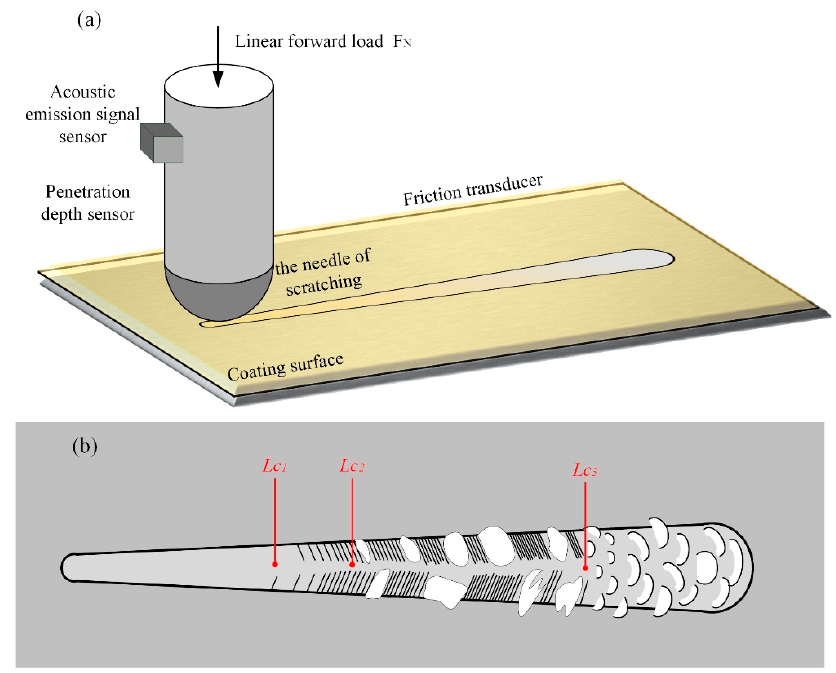
Figure 2. Scratch test: ( a ) schematic diagram; ( b ) schematic diagram of the judgment criteria for binding force.